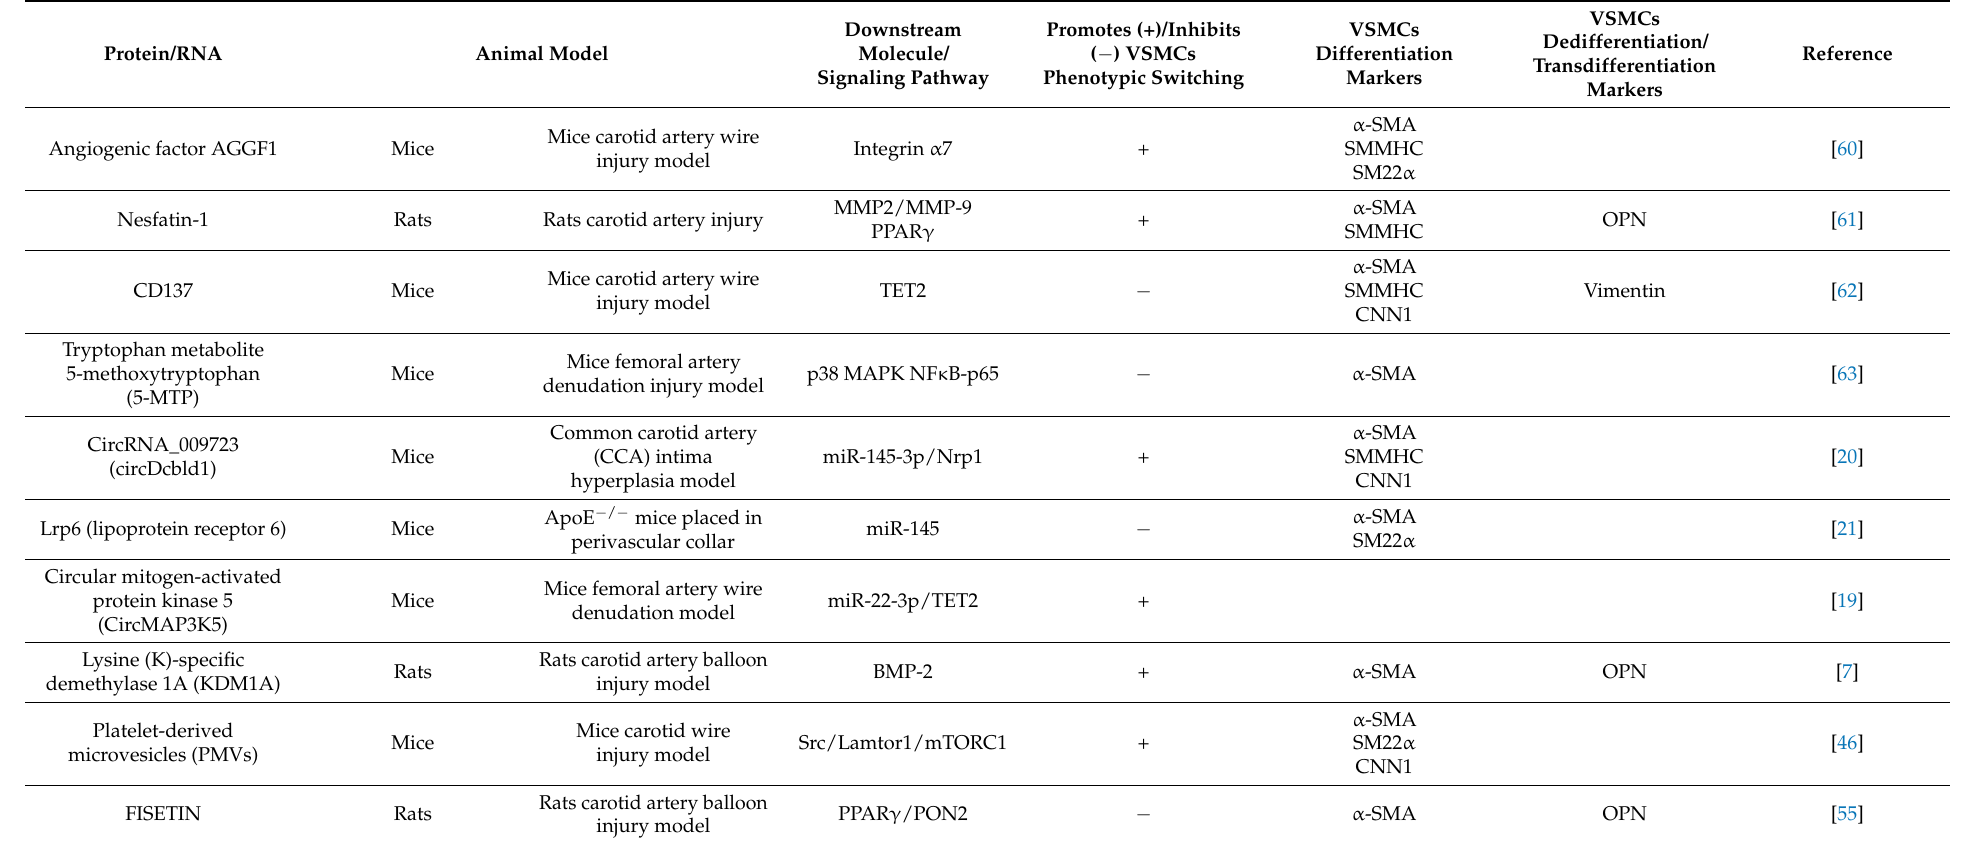
Table 2. Molecular mechanisms of VSMCs phenotypic switching in Neointimal